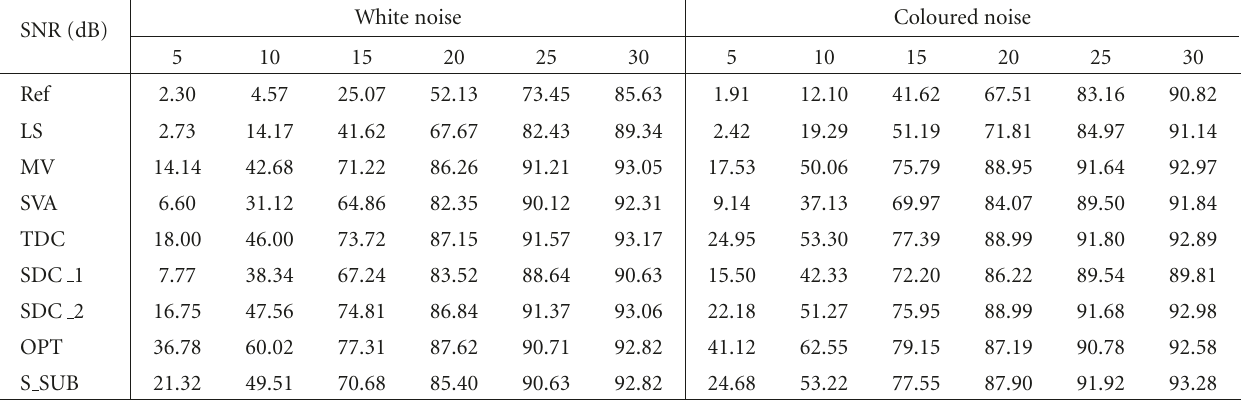
Table 2: Word recognition accuracies (%) with SVD-based speech enhancement—RM Feb89 test